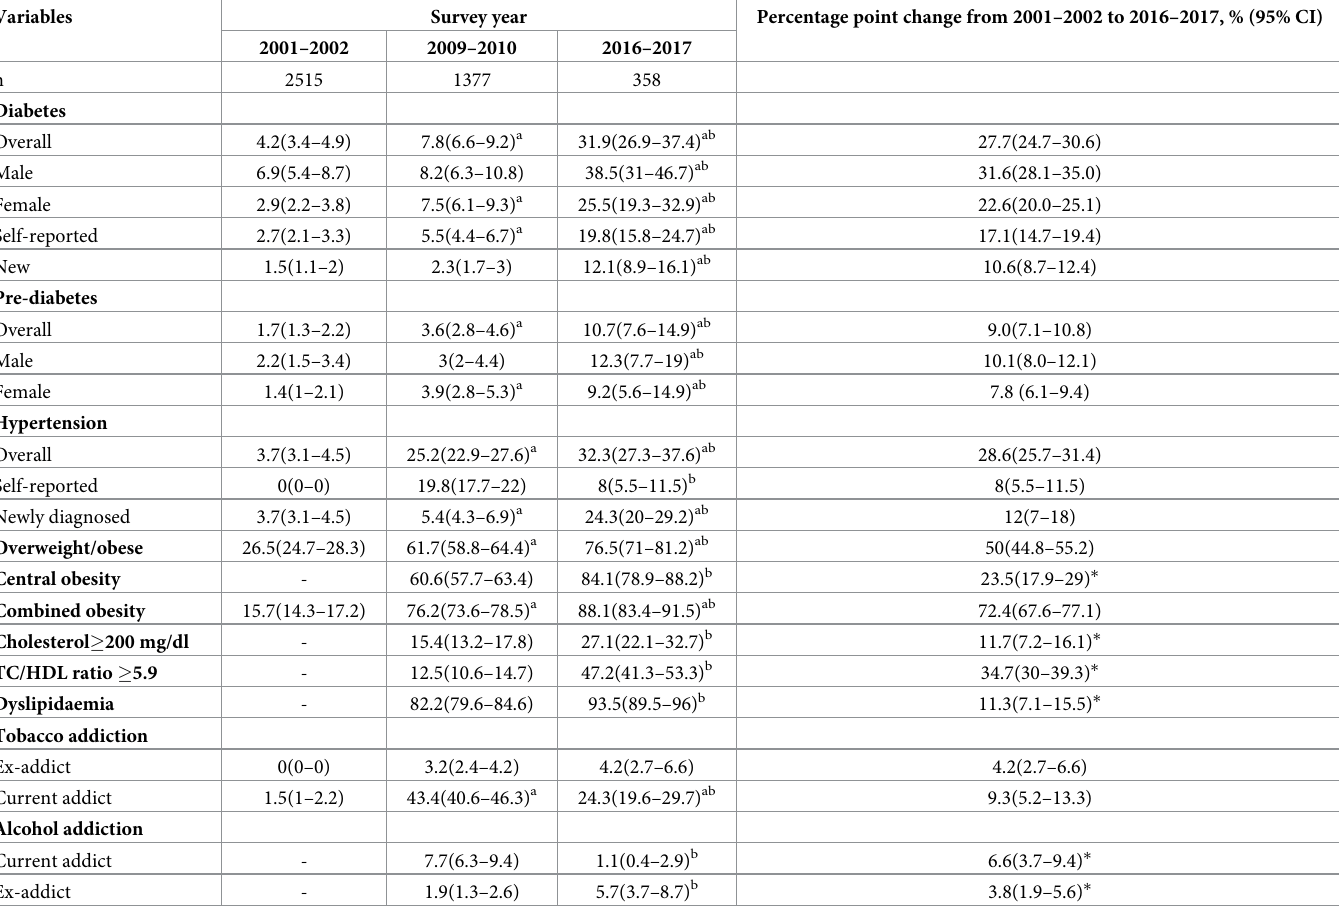
Table 2. Trends in prevalence of diabetes, obesity, hypertension, dyslipidaemia and tobacco and alcohol